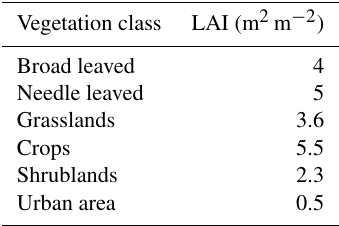
Table 7. Vegetation classes and LAI values used to build the LAI